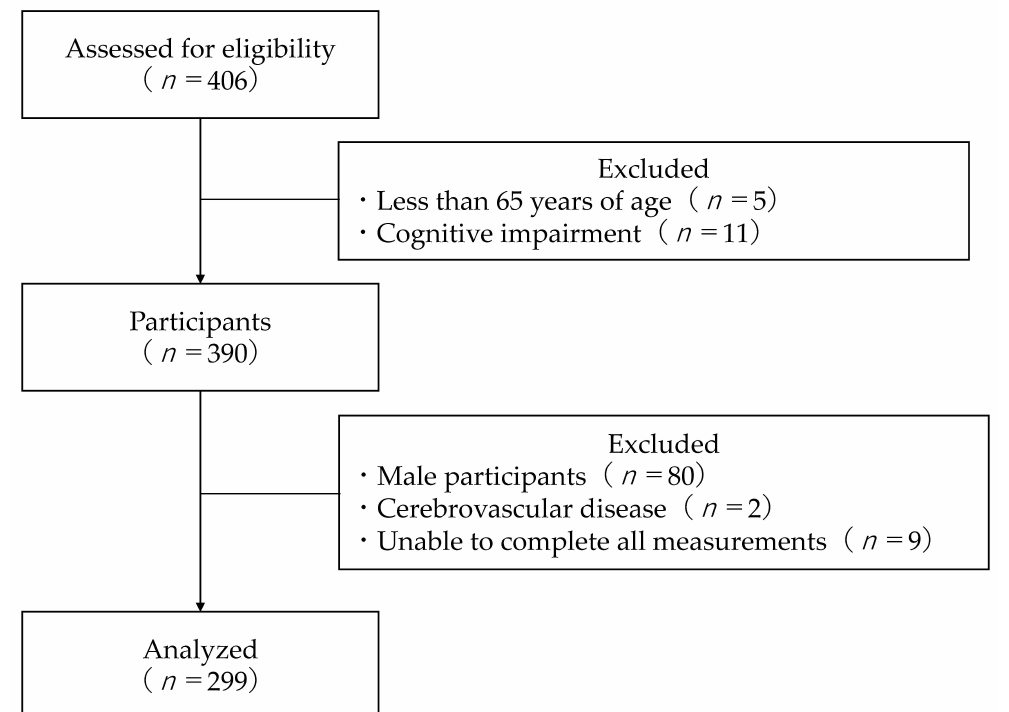
Figure 1. Flowchart of participation